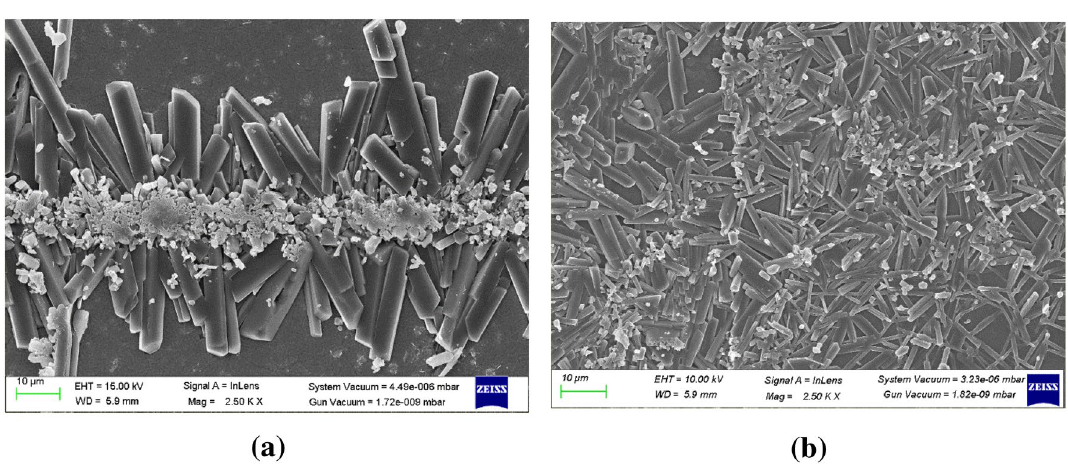
Figure 8. SEM structures of 5at.% ZnO:Ga thin films for ( a ) pristine and ( b ) irradiation with Ag 9+ ion beam.